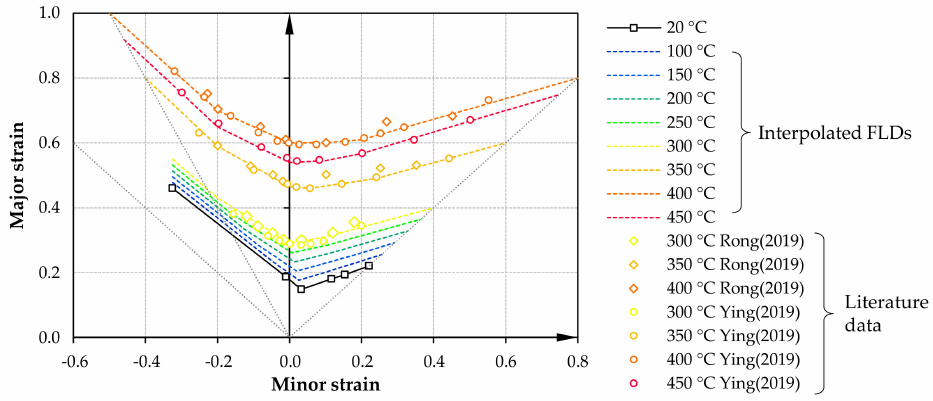
Figure 5. Assumption for TFLDs for AA7075 according to Rong et al. [37] and Ying et al.